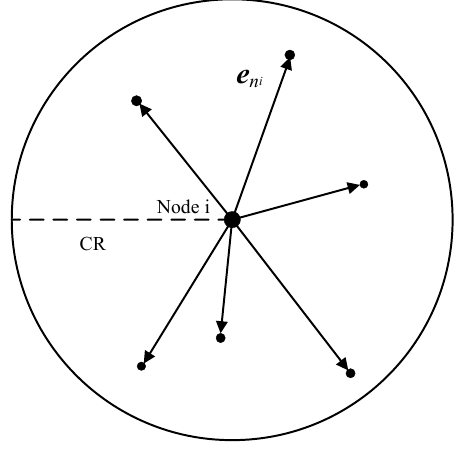
Figure 3. Orientation of sensor